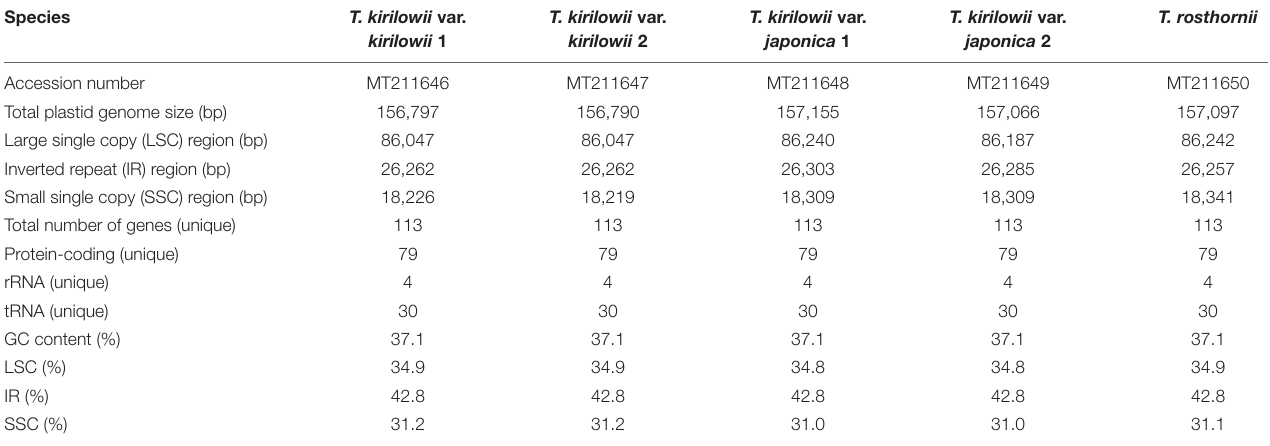
TABLE 1 | Features of Trichosanthes plastid genomes.